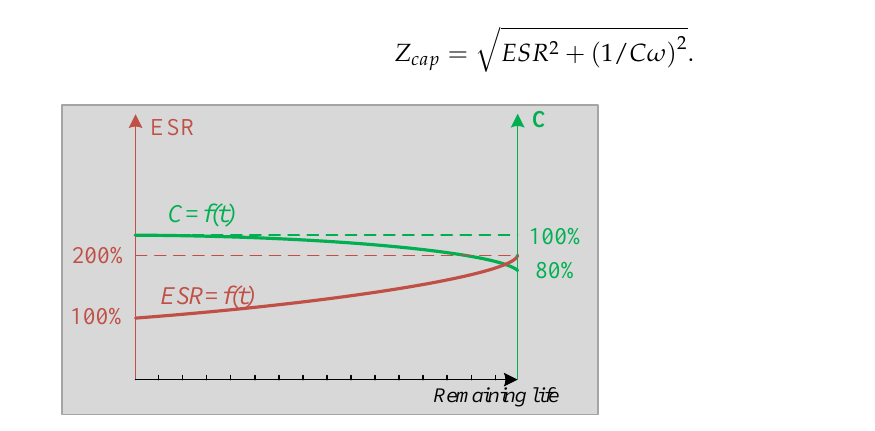
Figure 1. Indication curves of capacitor degradation.